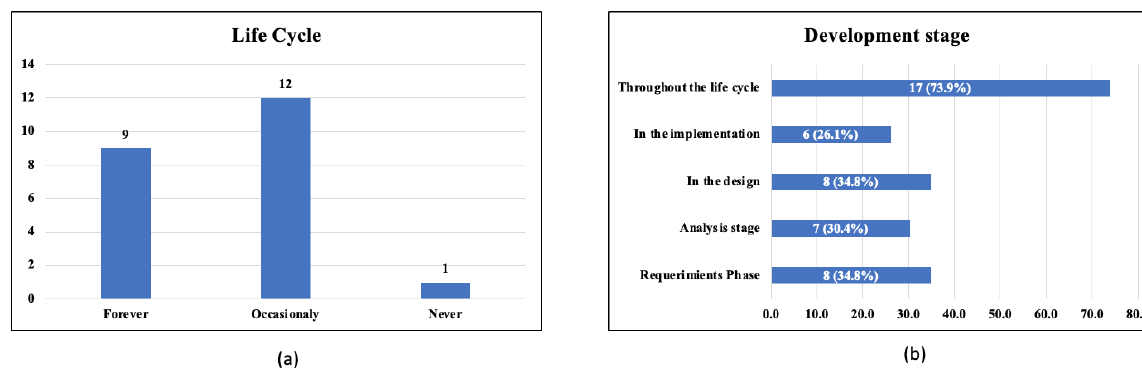
Figure 4. User participation in: (a) the development cycle, (b) different stages of development